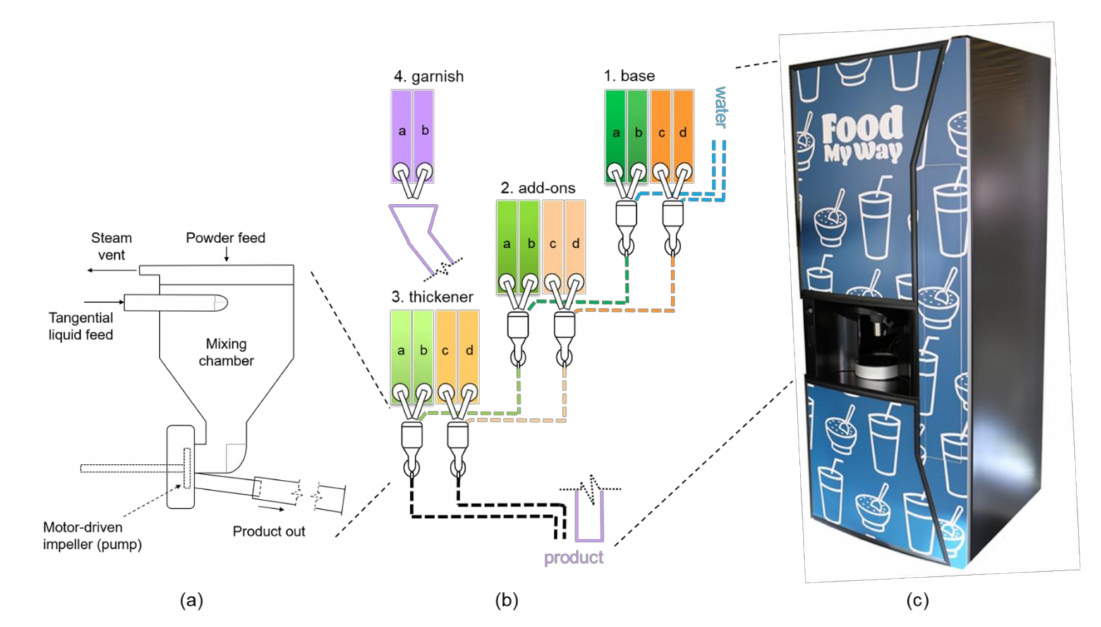
Figure 2. ( a ) Operating principle of motorized mixing bowl, ( b ) internal view of the Healthy